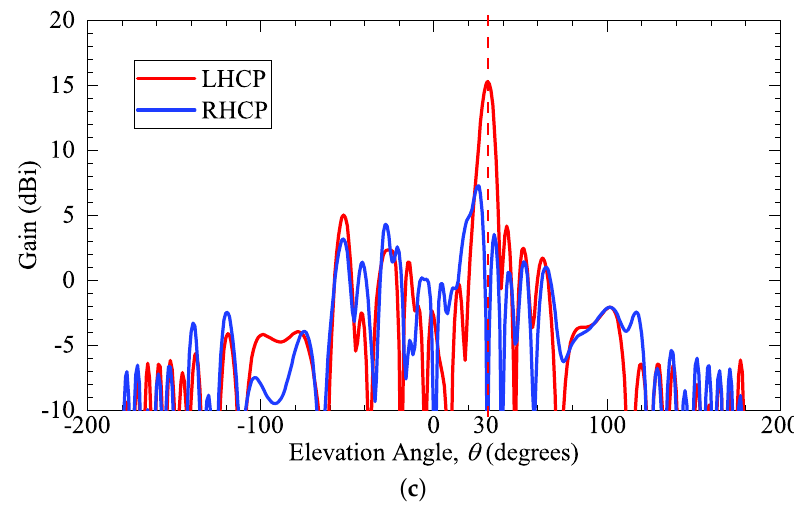
Figure 13. The E-plane radiation patterns obtained at 12 GHz when the antenna is excited by the ( a ) first, ( b ) second, and ( c ) both sources. 12 GHz. The metasurface is realized using Rogers RT/Duroid 5880 substrate of thickness 3.175 mm and a dielectric constant of 2.2. The average surface reactance and the modulation index are 255 and 31 ohms, respectively